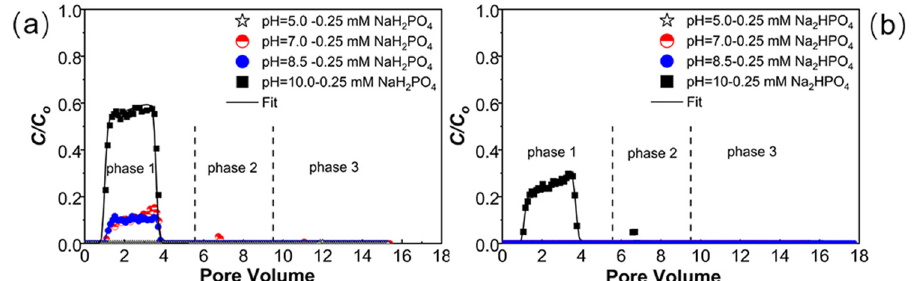
Figure 3. Breakthrough curves of PNPs at NaH 2 PO 4 (0.25 mM) under pH = 5–10 ( a ); breakthrough curves of PNPs at Na 2 HPO 4 (0.25 mM) under pH = 5–10 ( b ). All the experiments were carried out in the presence of 1 mM NaCl. The release of PNPs was initiated by eluting with ultrapure water under pH 7 (phase 2) and pH 10 (phase 3), respectively.